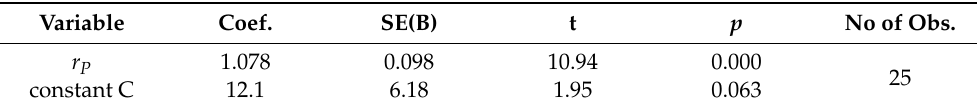
Table 6. Rankings before the tournament, predicted by the ranking of the preceding preliminaries (regression r T = B × r P +